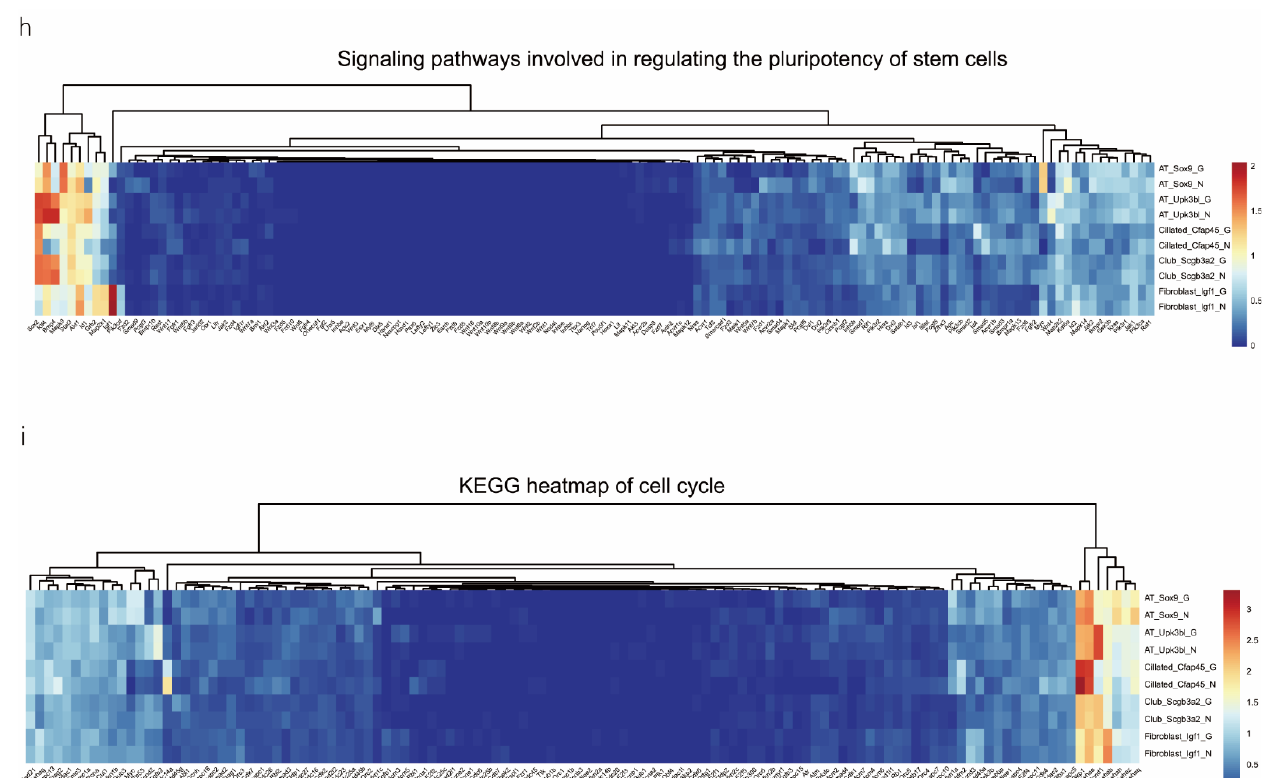
Figure 4. scRNA-seq reveals DEGs in AECs from normal control (NC) and phosgene-induced CALI model (Gas) groups. ( a ) Violin plots of the upregulated and downregulated DEGs in each cell cluster from the NC (blue violin) and Gas (red violin) groups. ( b ) Heatmap of the marker genes contributing from each cell subset. ( c ) Volcano plot of upregulated (red circles) and downregulated (blue circles) DEGs in SOX9-positive AECs from the Gas group compared with those in the SOX9-positive AECs from the NC group. GO term enrichment analysis of the ( d ) cellular component (CC), ( e ) biological process (BP), and ( f ) molecular function (MF) of the DEGs in NC and Gas group cells. ( g ) KEGG pathway analysis shows that the DEGs are mostly enriched in the PI3K-Akt signaling pathway. Heatmap of row-scaled expression of ( h ) signaling pathways regulating the pluripotency of stem